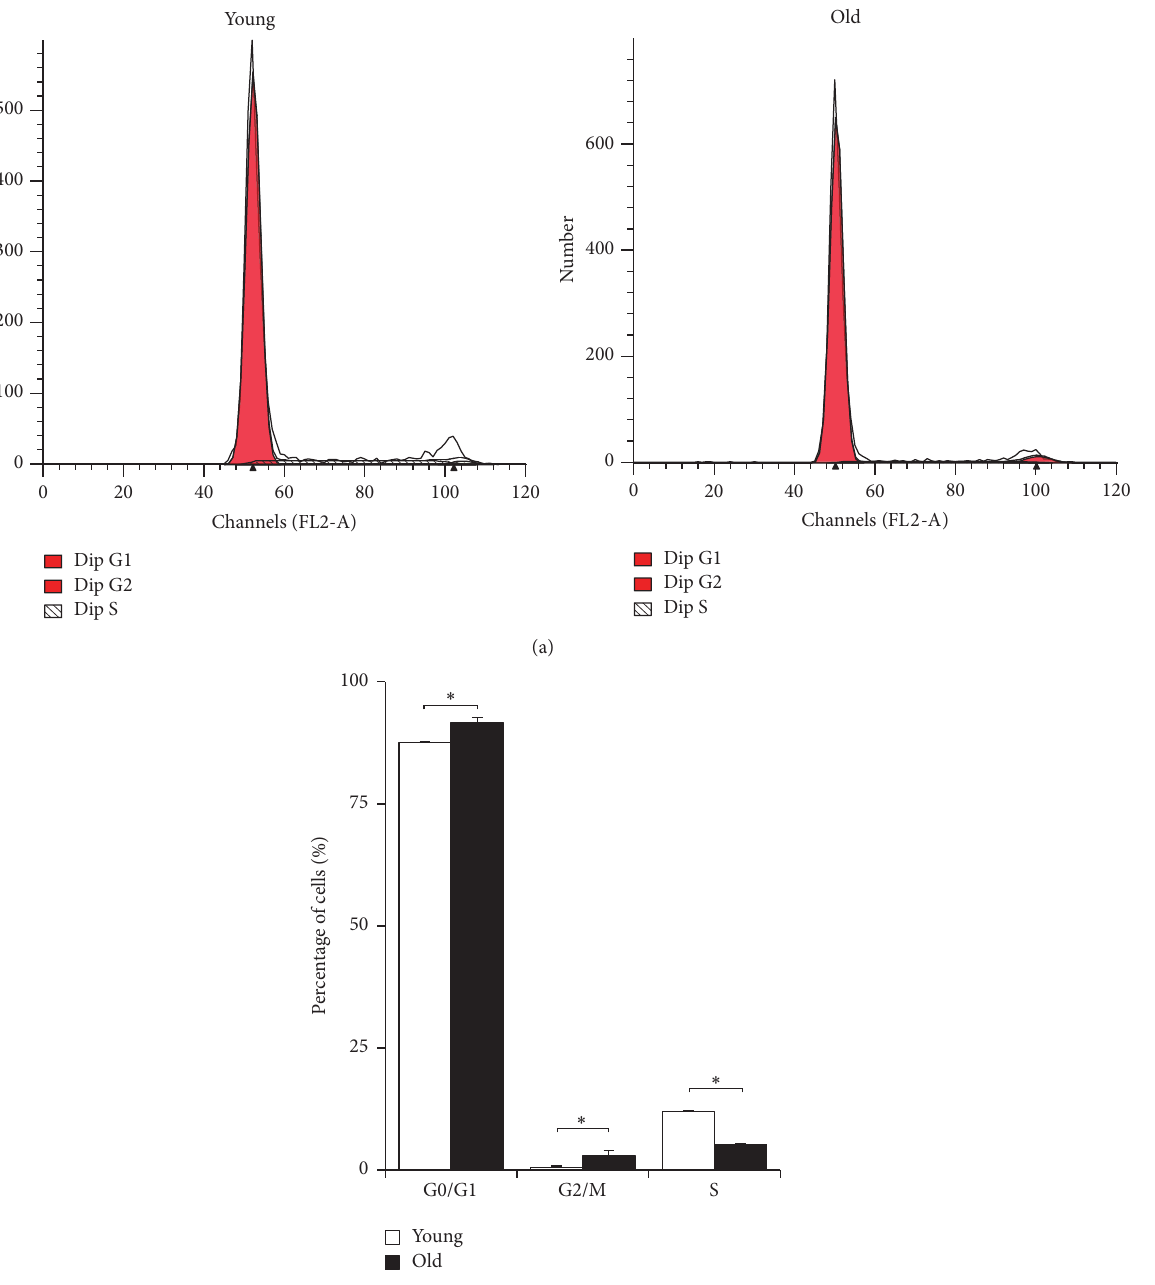
Figure 6: Cell cycles of NPMSCs ( 𝑛 = 5 ). (a) Representative graphs of cell cycles of young and old NPMSCs determined by flow cytometry. (b) Both young and old NPMSCs were mainly in the G0/G1 phase ( > 80%), but only small percentages of cells were in the G2/M and S phases. Furthermore, increased G0/G1 and G2/M phase arrest coupled with decreased S phase entry was observed in old NPMSCs compared to young NPMSCs. The data are expressed as means ± SD. ∗ indicates 𝑃 < 0.05